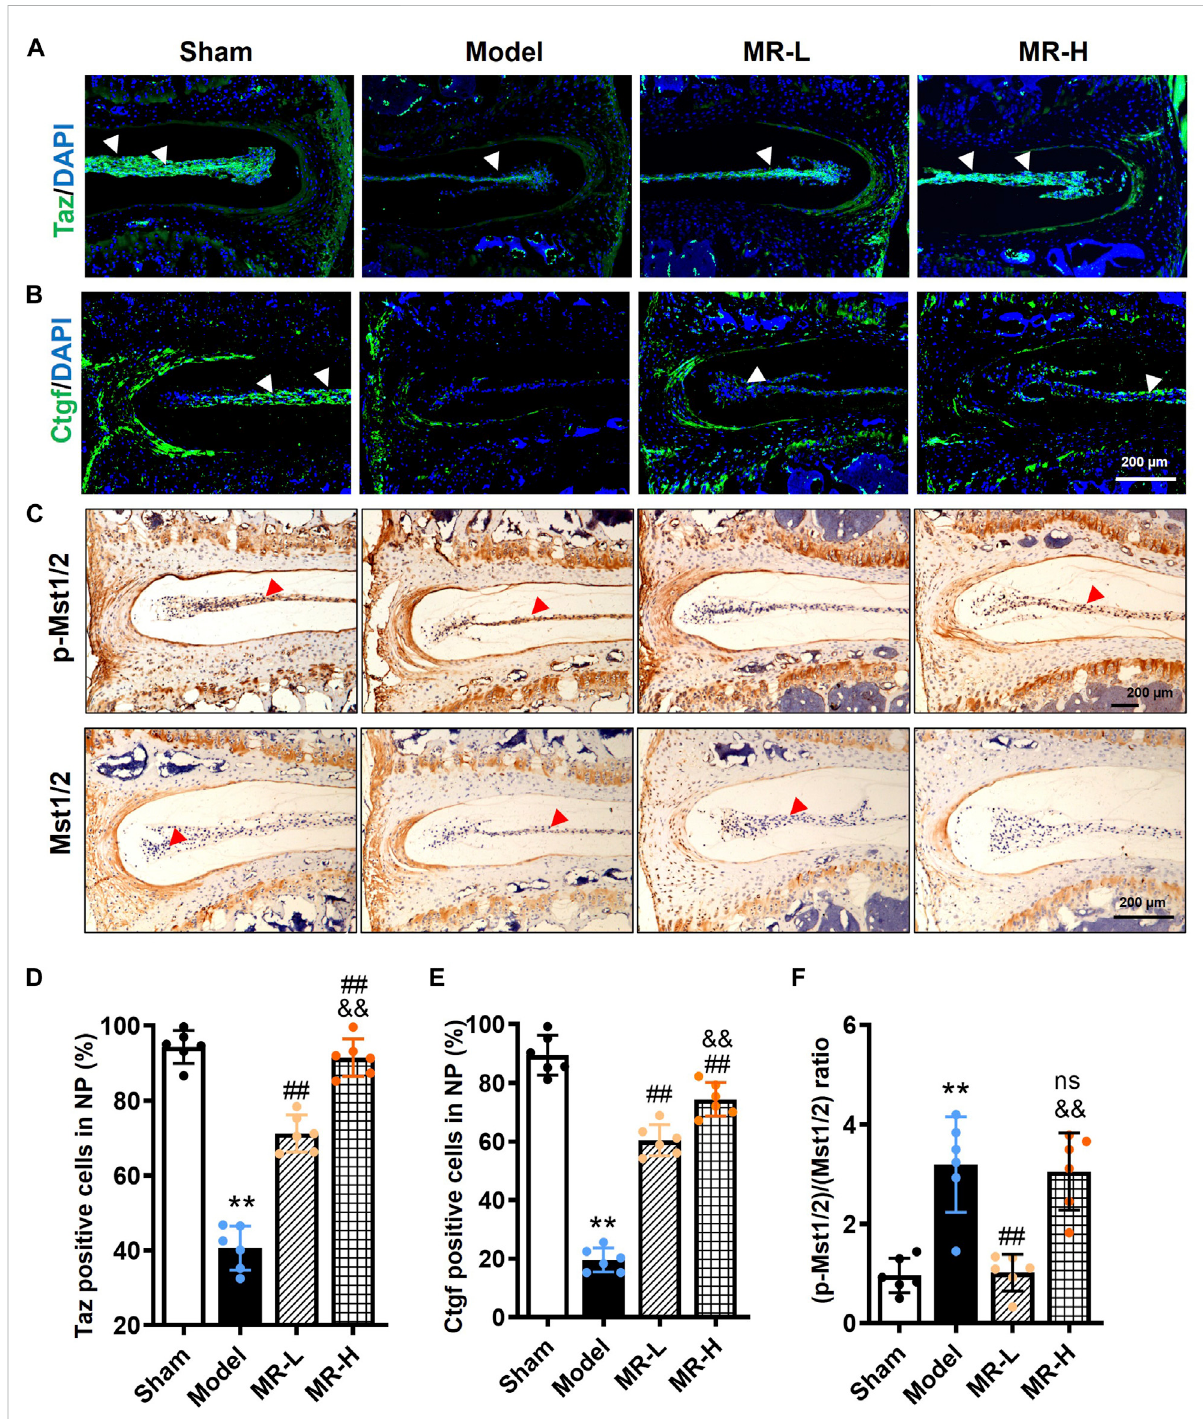
FIGURE 5 MR inhibits Hippo signaling of NP tissue in IVDD mice. (A,B) The IF staining results of Taz and Ctgf in NP tissues of mice. White arrowheads indicated positively-stained cells. (C) The IHC staining results of p-Mst1/2 and Mst1/2 in NP tissues of mice. Red arrowheads indicated positively- stained cells. (D,E) Quanti fi cation of Taz and Ctgf in (A,B) . (F) Quanti fi cation of the ratio of (p-Mst1/2)/(Mst1/2) in (C) . Data are expressed as mean ± SD, **p < 0.01 (vs. Sham group); #p < 0.05, ##p < 0.01 (vs. IVDD group), &&p < 0.01 (vs. MR-L group), n = 10 per